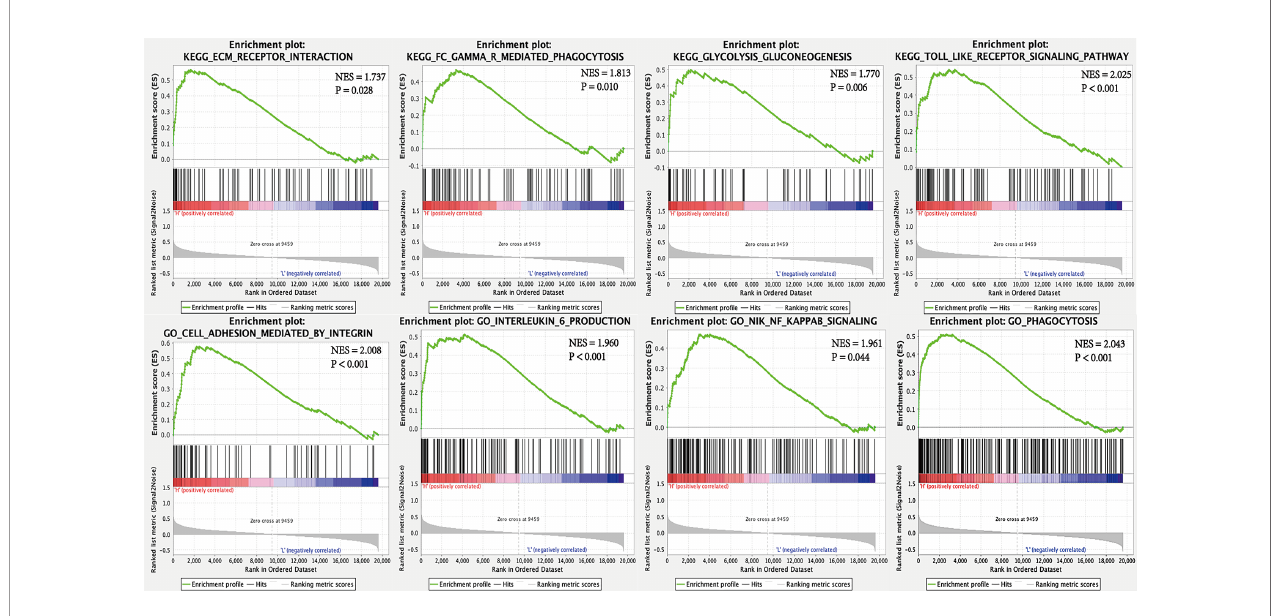
FIGURE 4 | GSEA for high and low SPP1 expression